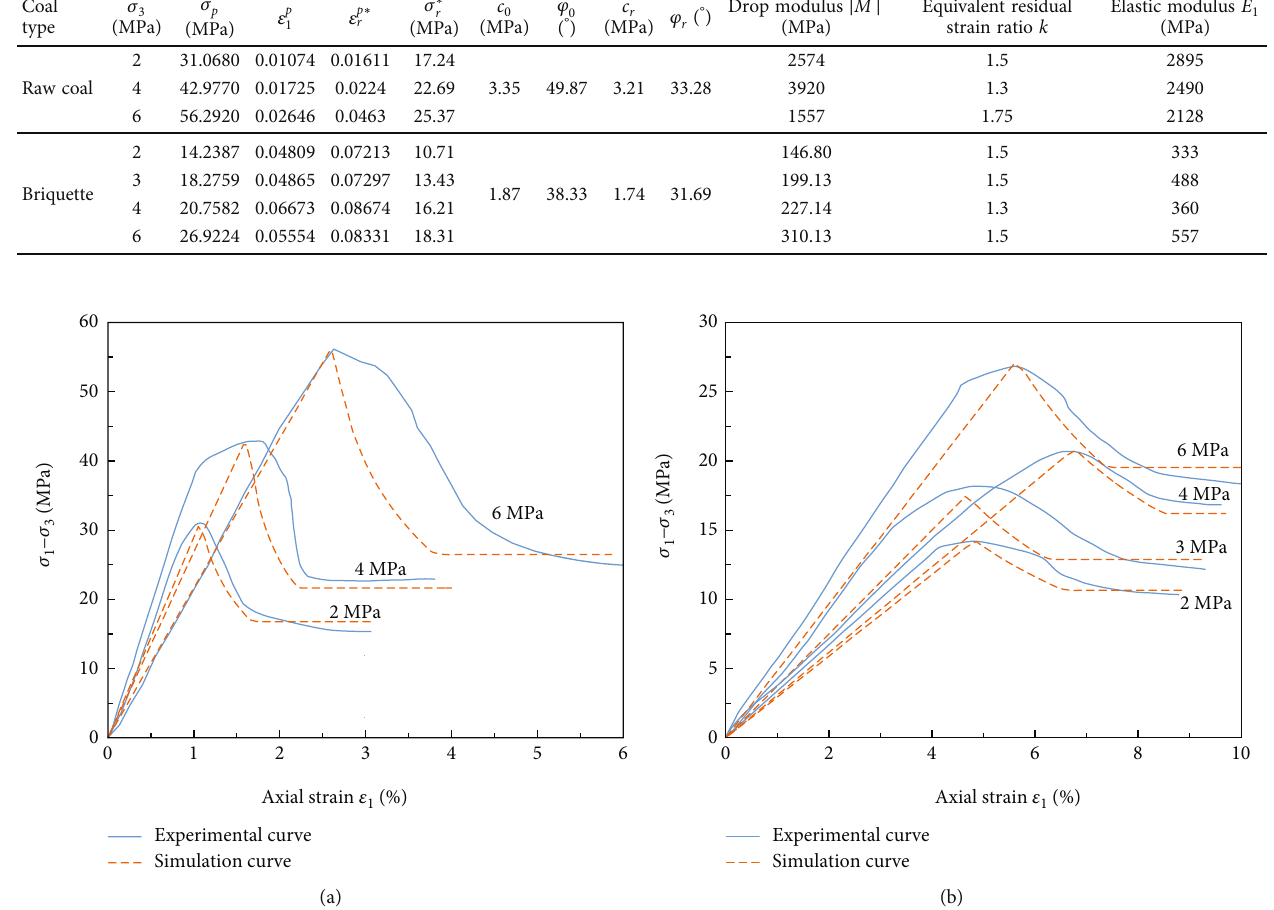
Figure 14: Comparative analysis of numerical simulation results and experimental results: (a) raw coal and (b) briquette composed of soft